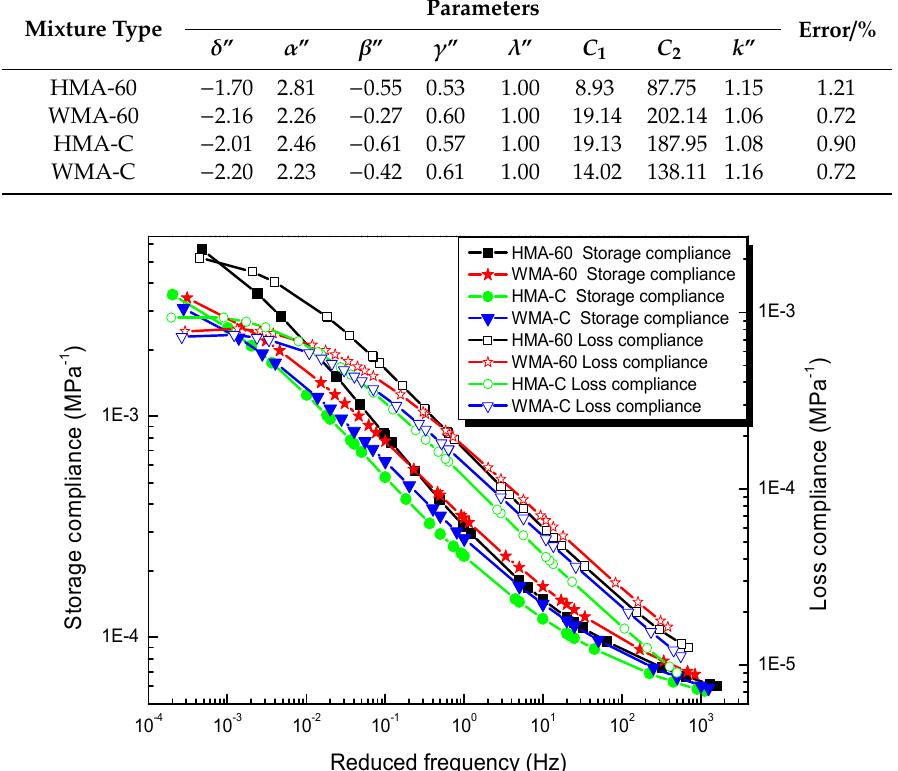
Figure 4. Master curve of storage compliance and loss compliance. Table 6. GSM fitting parameters for storage compliance and loss compliance.